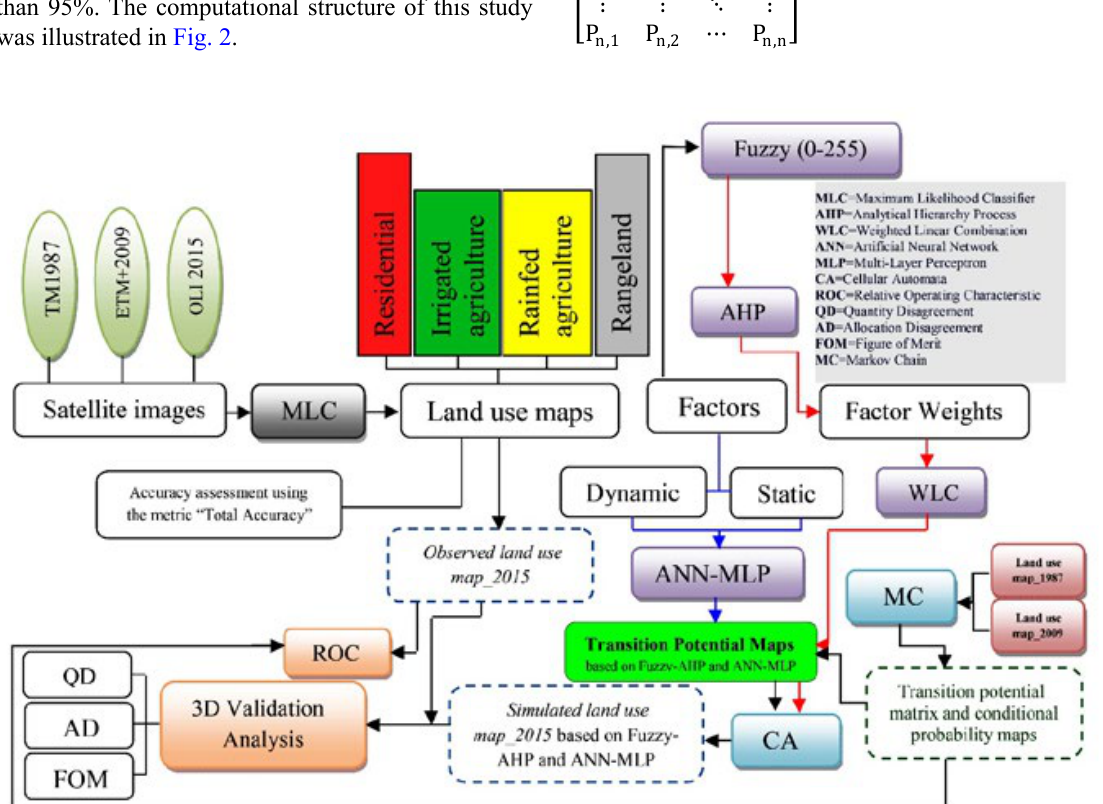
Fig. 2: Computational framework of the study